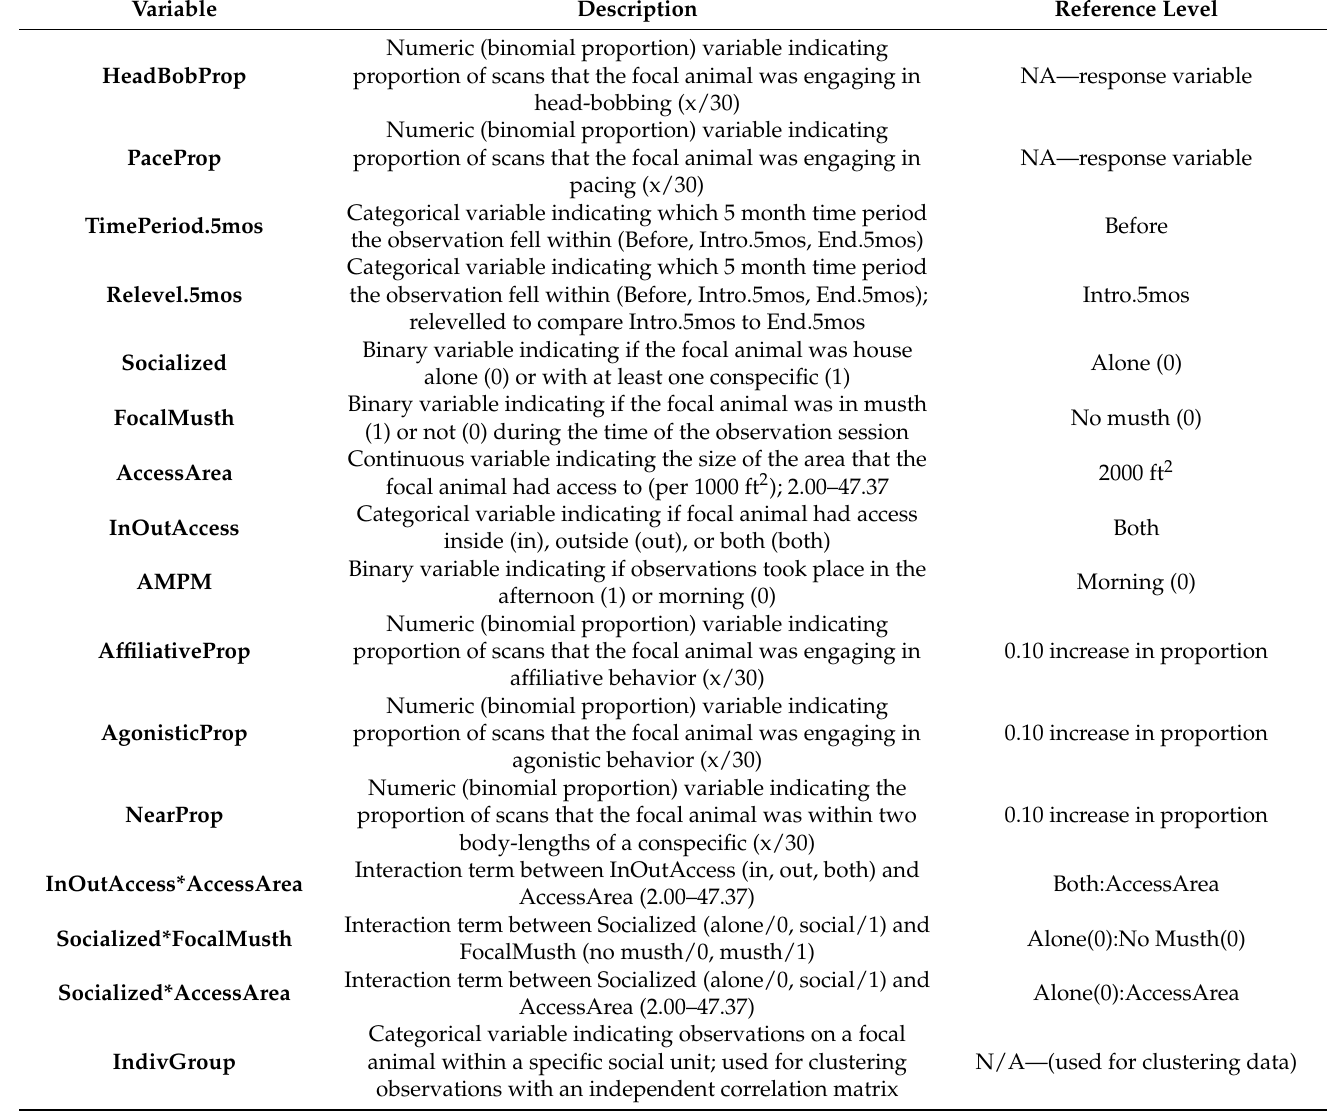
Table 2. Description of Variables Considered in Our Generalized Estimating Equations (GEE) [35,36]. Reprinted by permission of the publisher (Taylor & Francis Ltd., http://www.tandfonline.com accessed on 28 January